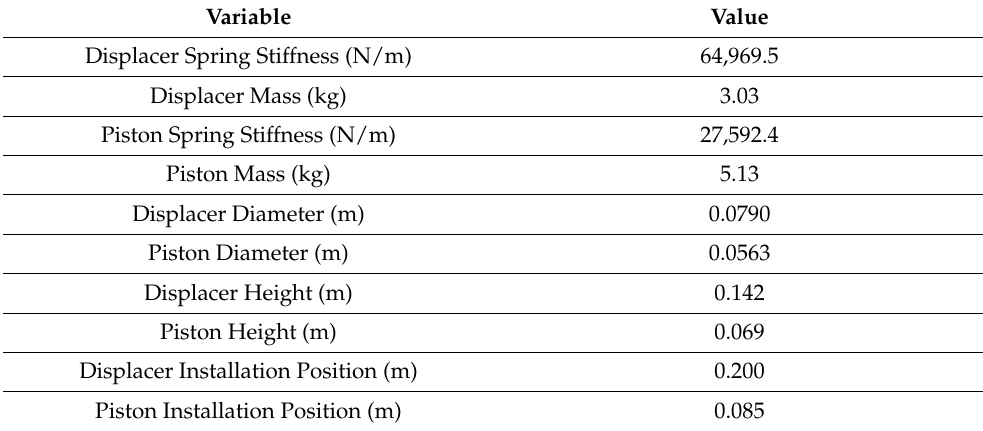
Table 4. Optimal design of Case 2.